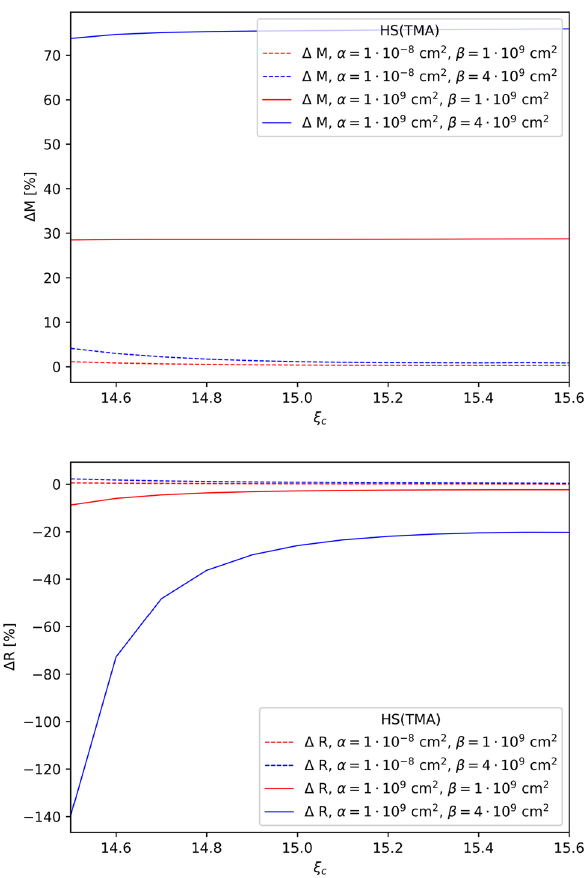
Fig. 17 Difference between the mass (upper panel) and the radius (lower panel) obtained, given a central density value ξ , with f ( R , Q ) = R + α R 2 + β Q and GR, for the HS(TDA) EoS